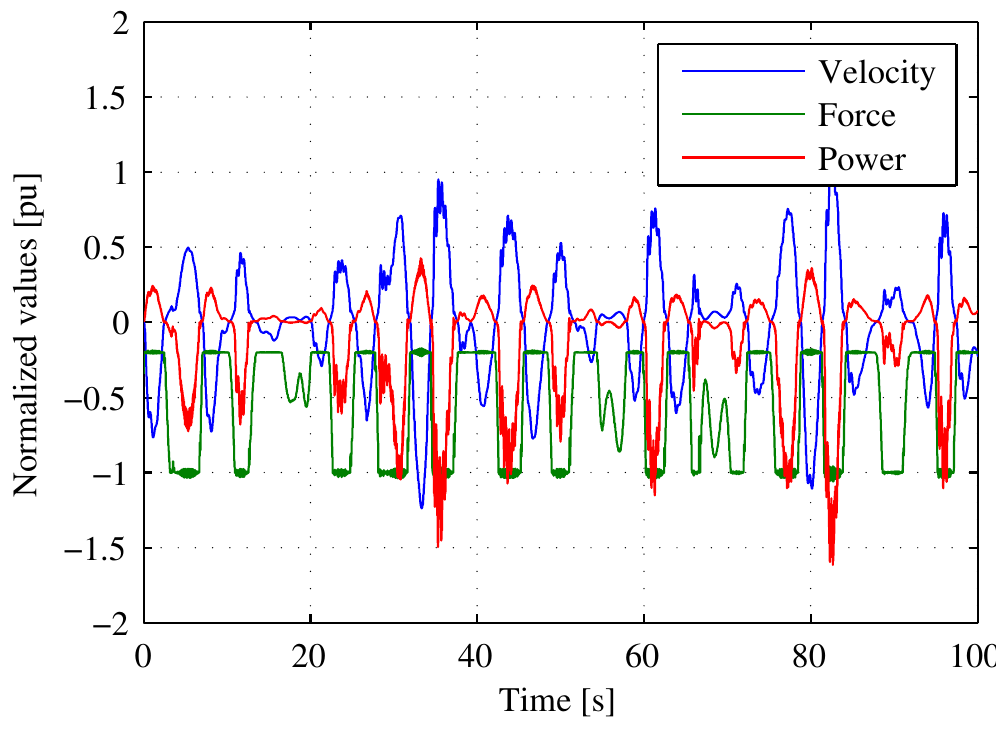
Figure 2. Actual production and system operation measured with Lifesaver.